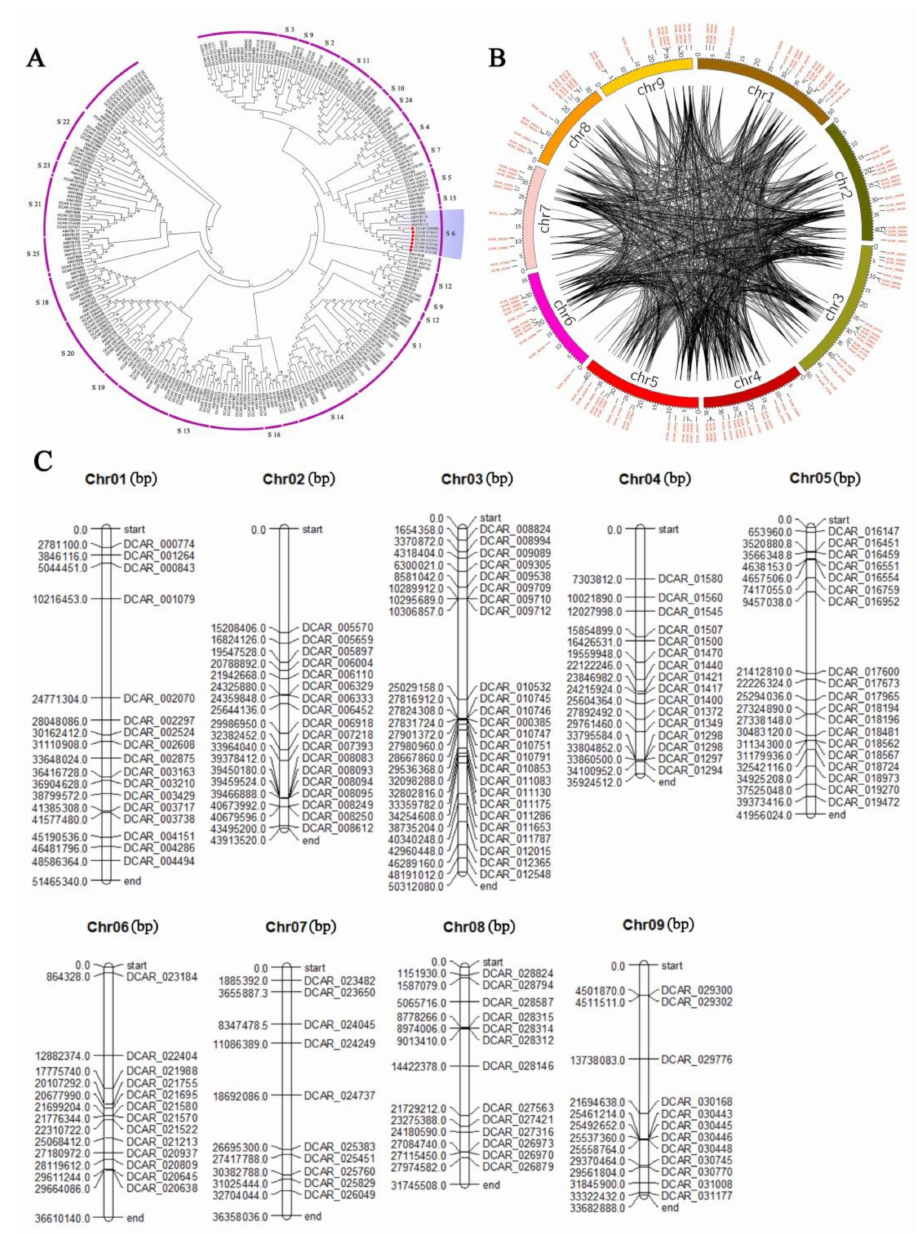
Figure 2. Phylogenetic tree of R2R3-MYB TFs of Arabidopsis and carrot and chromosomal determi- nation and collinearity analysis of R2R3-MYB genes in carrot. Phylogenetic trees were constructed from the R2R3-MYB protein sequence of carrot and Arabidopsis ( A ). The phylogenetic trees were established by the neighbor-joining (NJ) method. ( B , C ) represent the carrot chromosomes. The black lines represent collinear gene pairs. The genes were mapped onto different chromosomes and the numbers along the chromosome boxes represent sequence lengths in